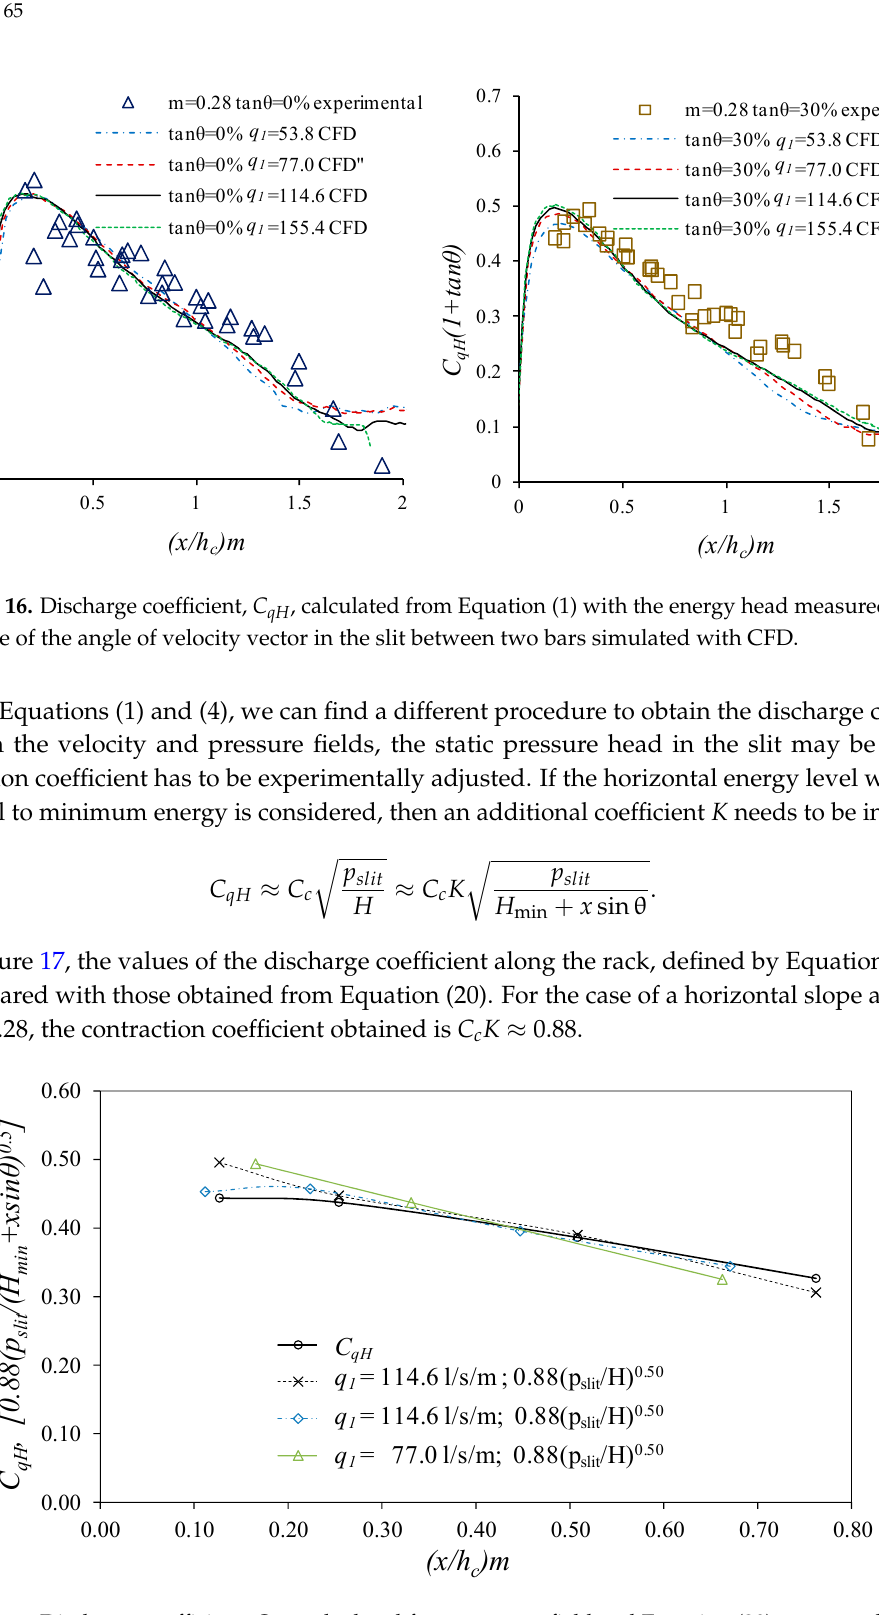
Figure 17. Discharge coefficient, C qH , calculated from pressure field and Equation (20), compared with values calculated from Equation (1).